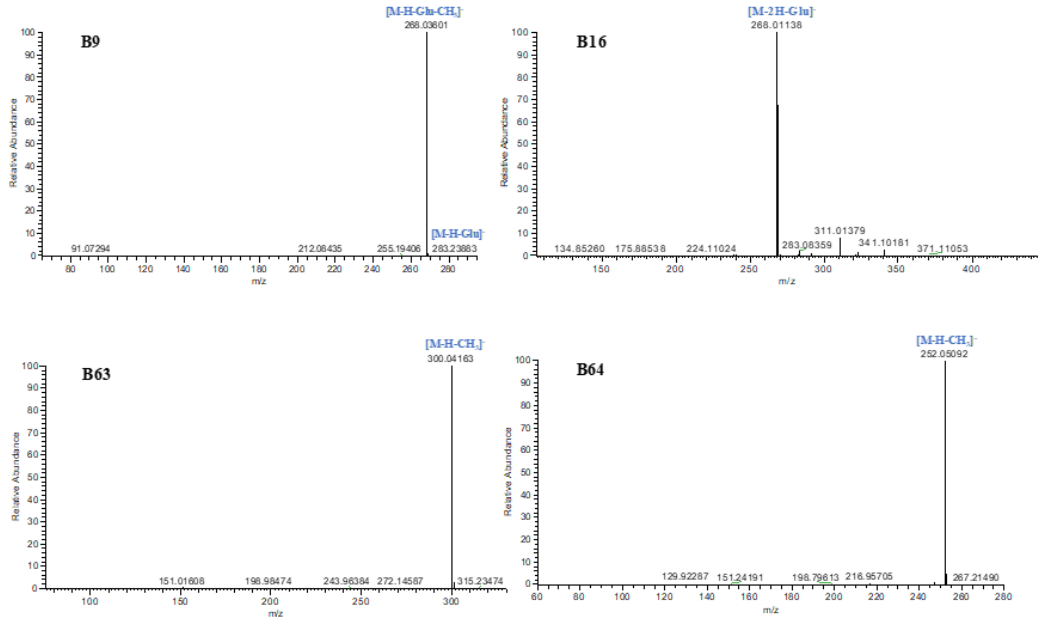
n spectra of B9 , B16 , B63 , and B64 Figure 4. The ESI-MS n spectra of B9, B16, B63, and B64. Figure 4. The ESI-MS